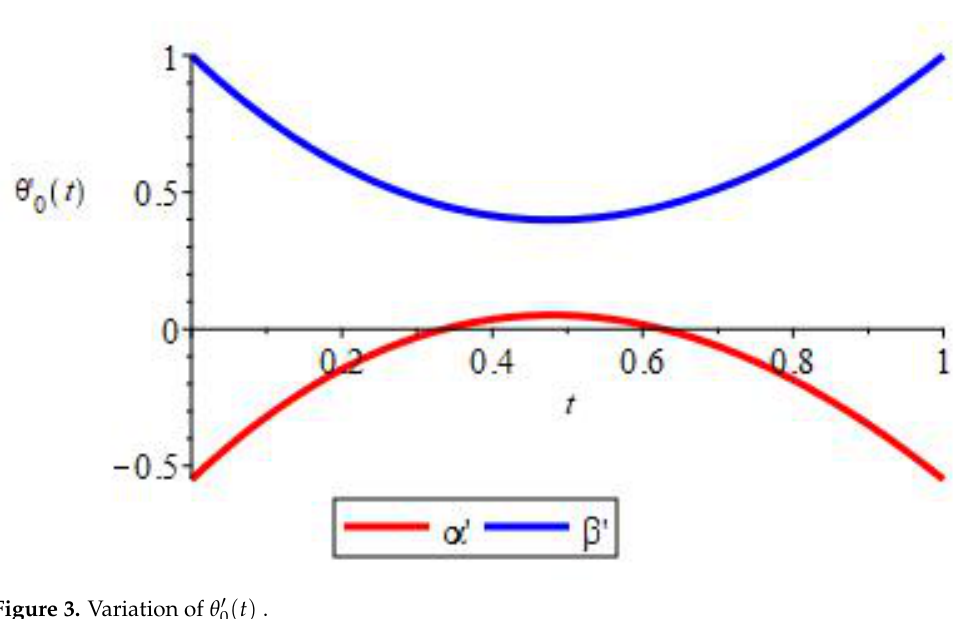
Figure 3. Variation of θ (cid:48)